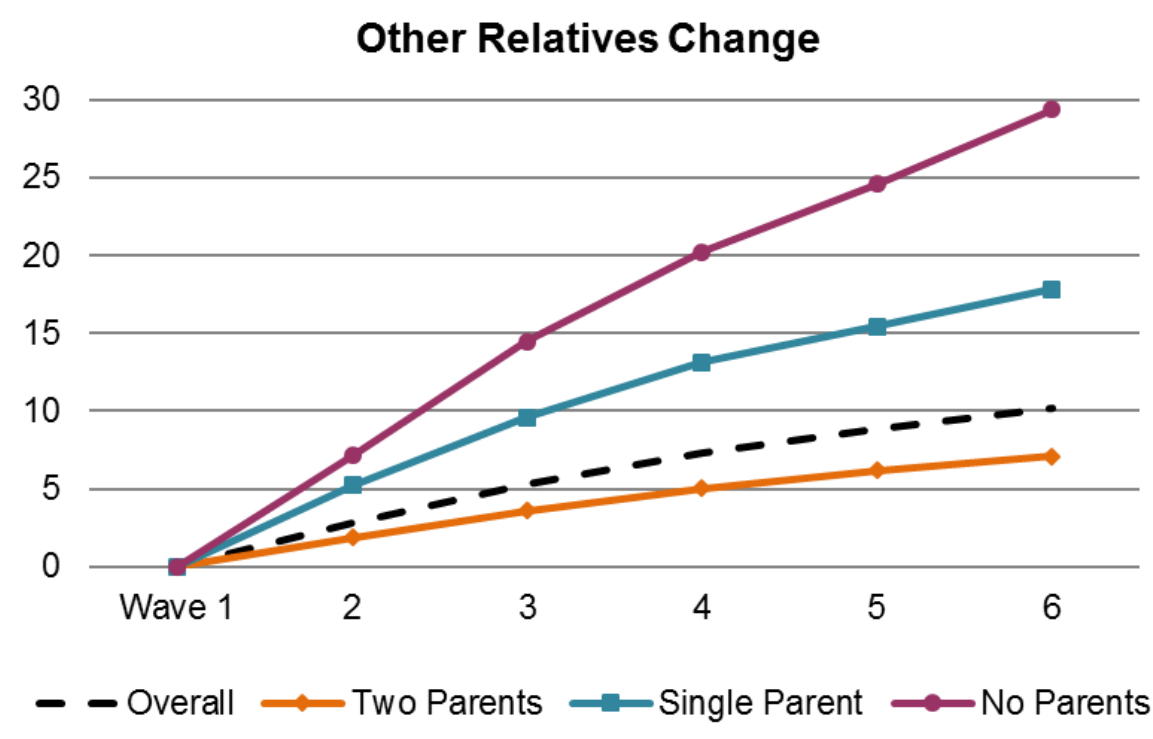
Figure 2: Weighted cumulative percent of children (by family structure) exposed to other relatives leaving and joining